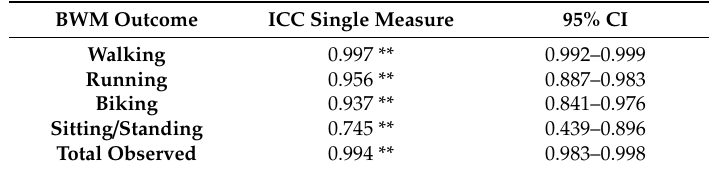
Table 2. Comparisons between traditional BWM and expert reviews of BWM videos using intraclass correlation coe ffi cients and paired t